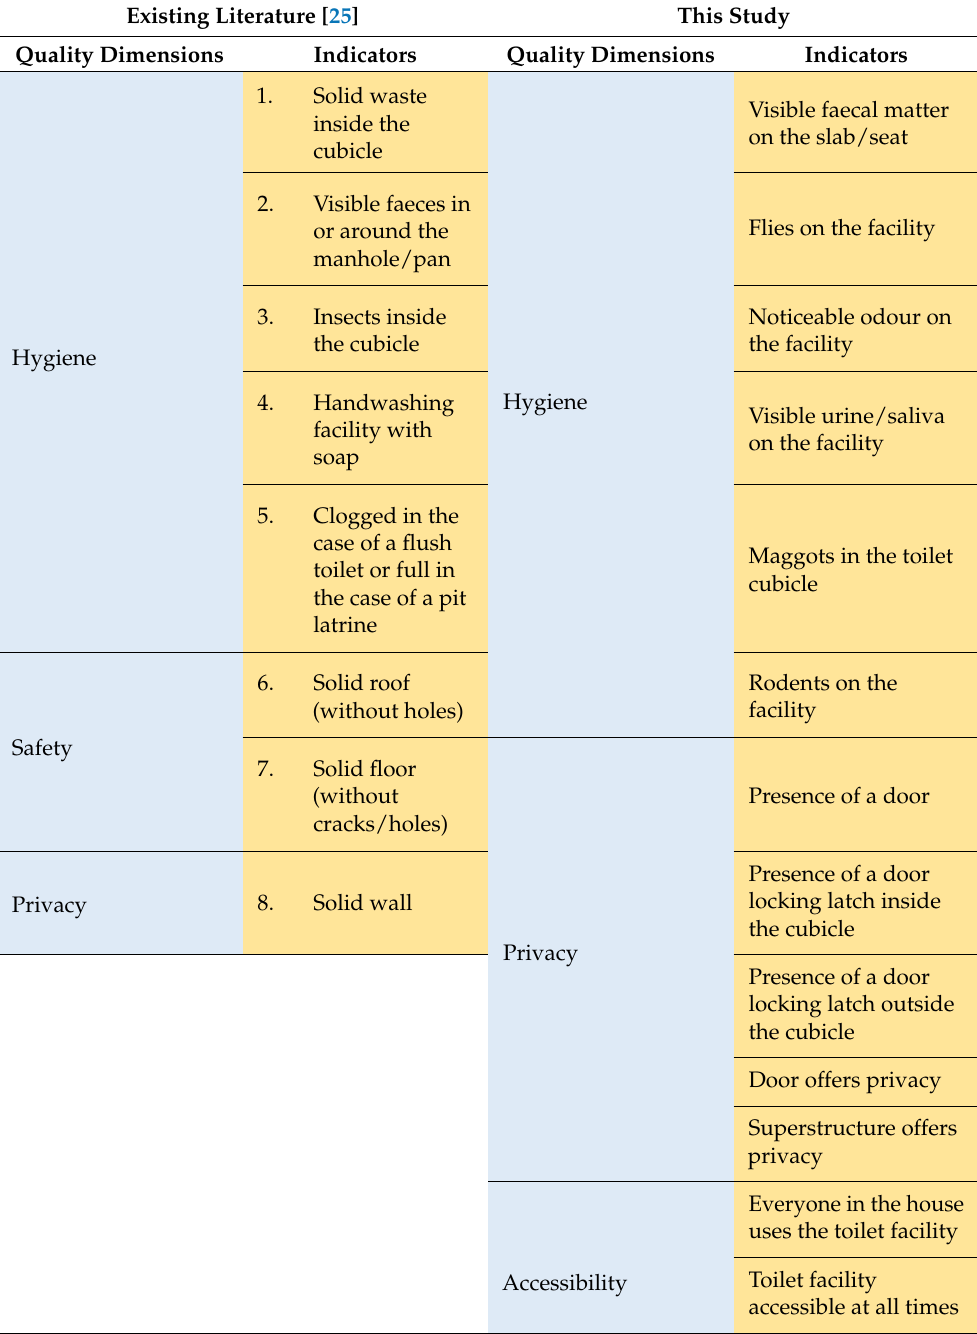
Table 1. Comparison of indicators used in previous studies and the current study. Existing Literature